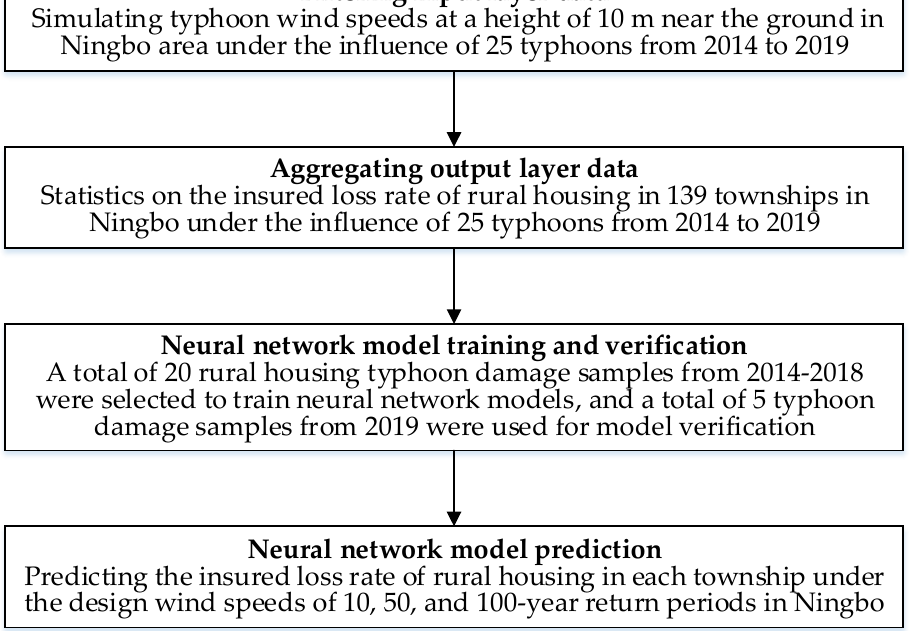
Figure 3. BP neural network structure.